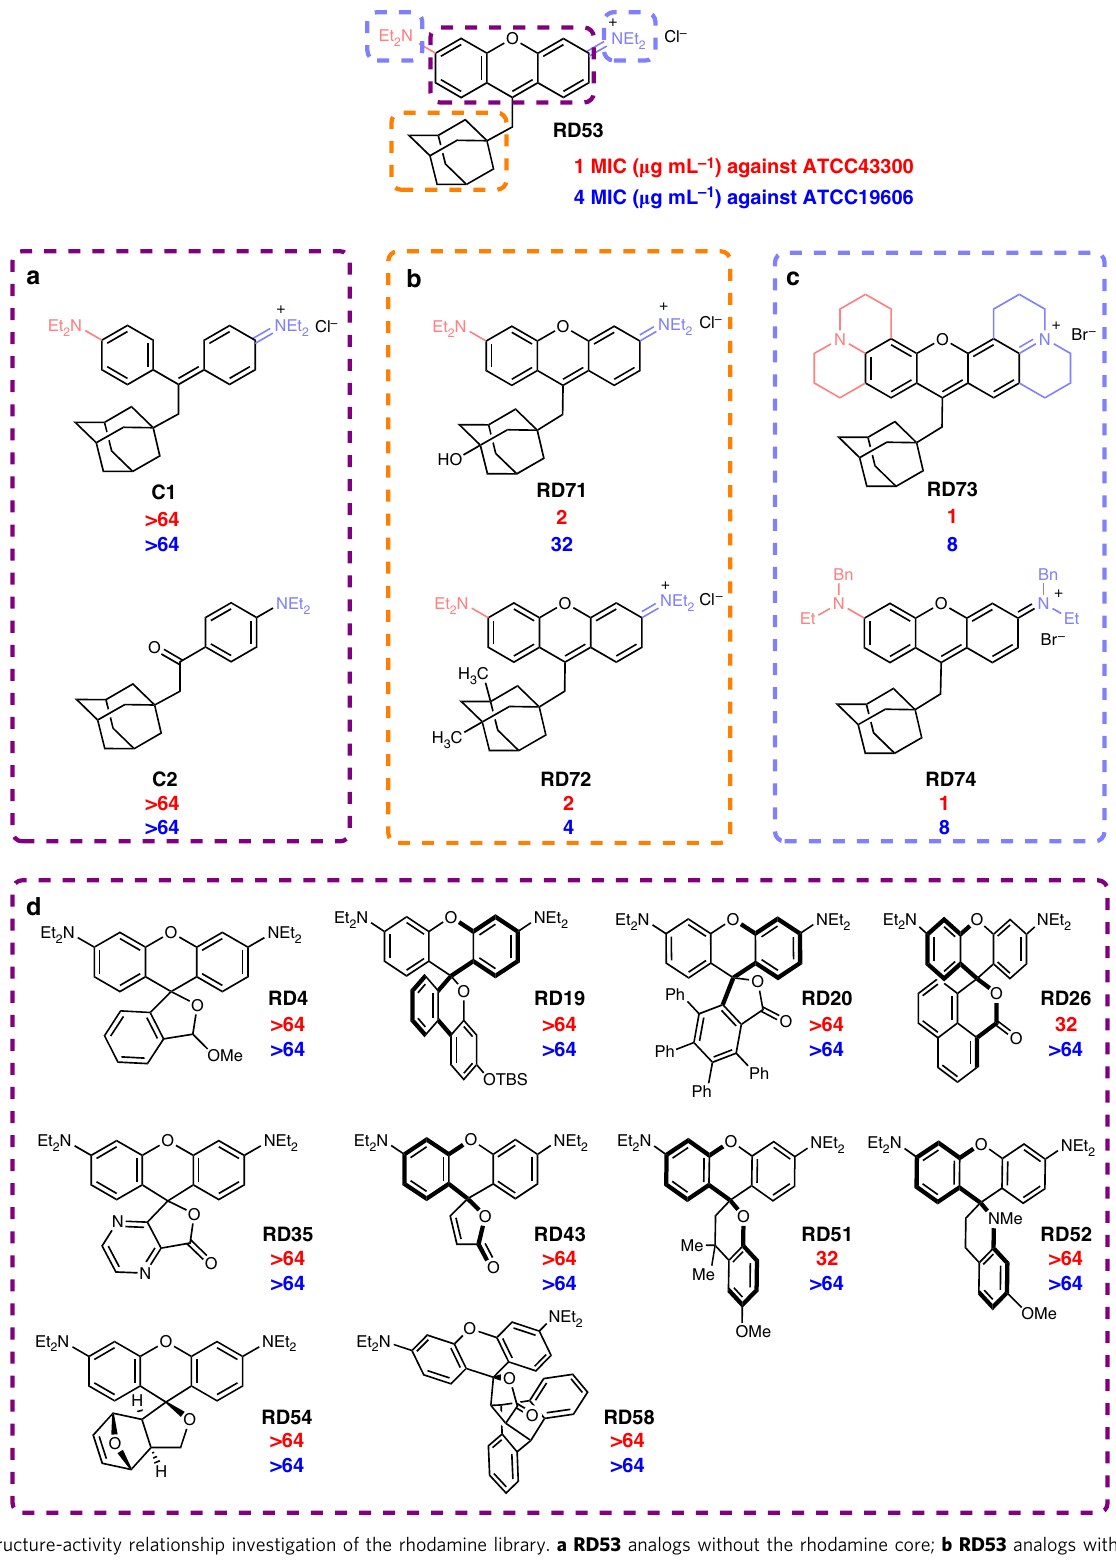
Fig. 7 Structure-activity relationship investigation of the rhodamine library. a RD53 analogs without the rhodamine core; b RD53 analogs with the adamantine moiety modi fi ed; c RD53 analogs with the diethylamino group modi fi ed. d Rhodamine dyes mainly adopted the ring-close forms exhibit no antibacterial activity against ATCC43300 or ATCC19606, with MIC > 64 μ g mL −